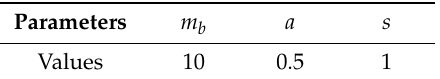
Table 2. The parameters of the Hoek-Brown failure criterion used for the soil strength of the embankment material in SLOPE / W.